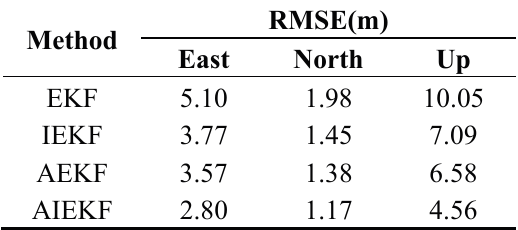
Table 1. Position errors of the EKF, IEKF and AIEKF